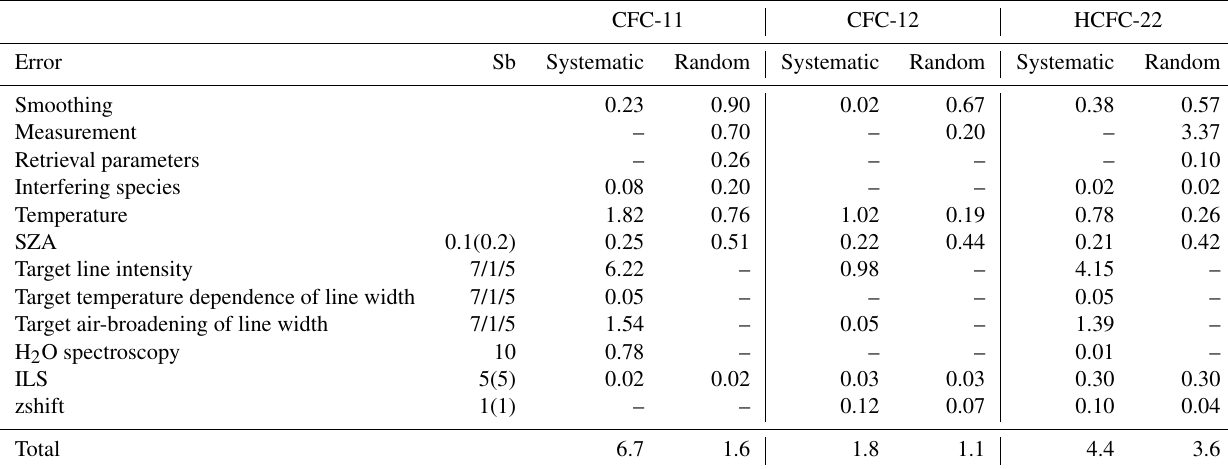
Table 3. Same as Table 2, but for